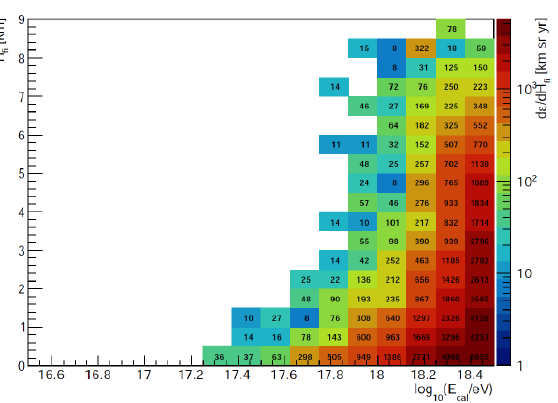
Figure 8. Double di ↵ erential exposure with log10( E cal / eV) on the x-axis and the height of first interaction on the y-axis for upward-going events